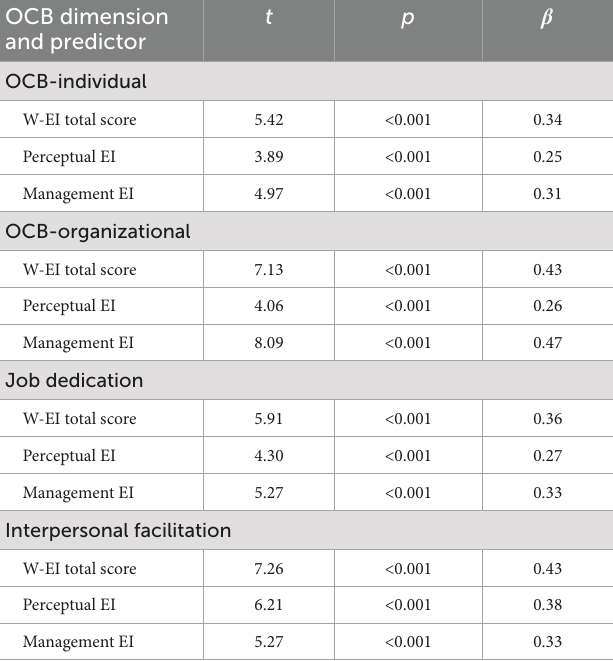
TABLE 3 Work-related emotional intelligence (W-EI) as a predictor of organizational citizenship behavior (OCB), simple regression results, Study